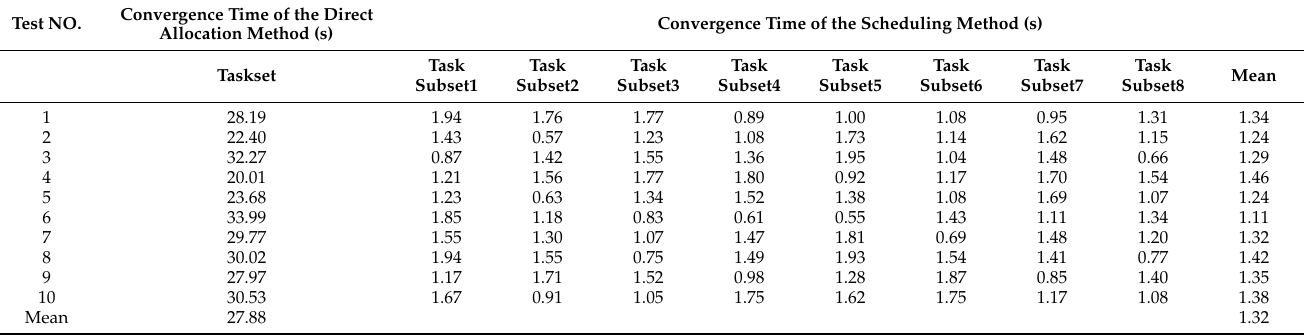
Table 6. Results data of 10 tests of the direct allocation method and the scheduling method.